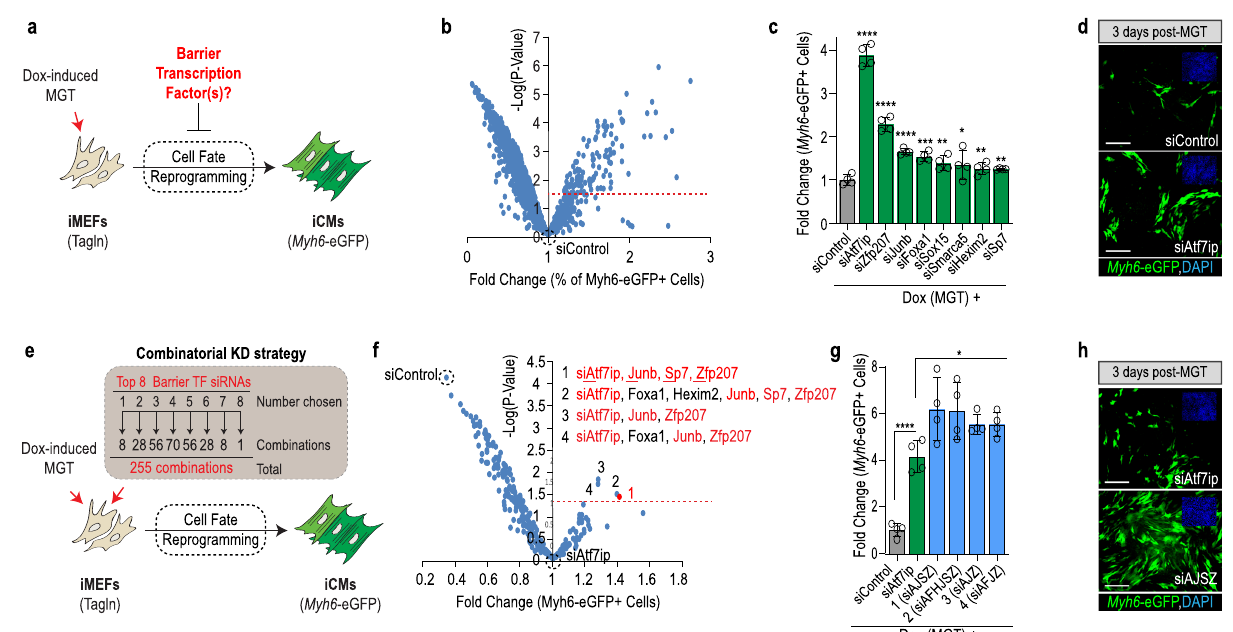
Fig. 1 | Genome-wide TF screen identi fi es Atf7ip, JunB, Sp7, and Zfp207 (ZNF207) as barriers to cell fate reprogramming. a Schematic of the cardiac reprogramming assay and experimental rationale. b Volcano plot depicting genome-wide TF screen results. X-axis shows % of Myh6-EGFP+positive normal- ized to siControl. Y axis represents − log of P value as compared to siControl. The screenwasrun in experimentalquadruplicate. c Validation oftop20 hits identi fi es eight siRNAs with con fi rmed activity. Student ’ s t -test: * p <0.05, ** p <0.01, *** p <0.001, and **** p <0.0001. d Representative images of top hit siAtf7ip- and siControl-transfected iMGT-MEFs on day 3 after MGT induction. Myh6-eGFP is showningreenandnucleiarestainedwithDAPI(blue,toprightinsets). e Schematic of the combinatorial screening approach. A total of 255 combinations was tested, eachinquadruplicate. f Volcanoplotdepictinggenome-widecombinatorialscreen